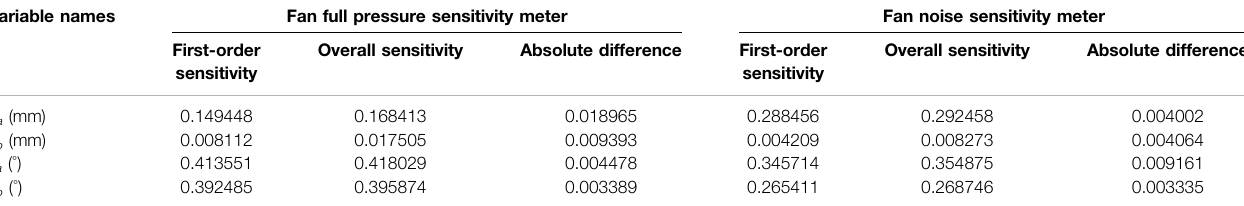
TABLE 2 | Fan sensitivity meter.